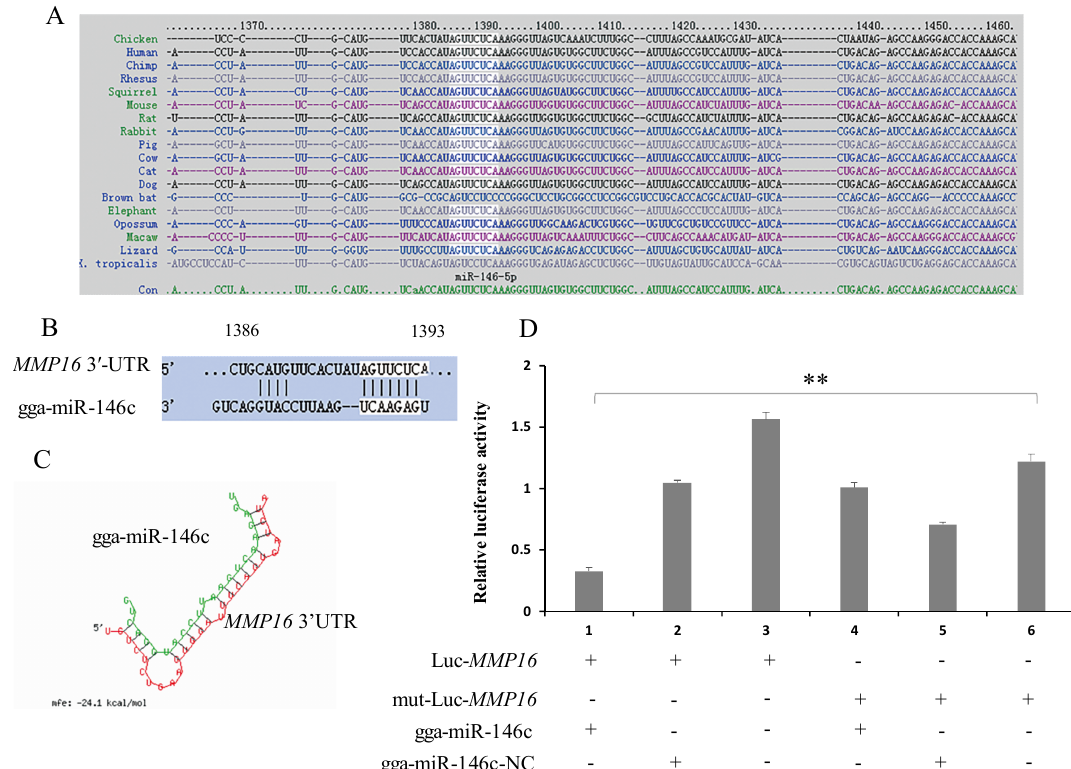
Figure 2. MMP16 is a target of gga-miR-146c. ( A ) Alignment of MMP16 3′-UTR from different species. The highlighted sequence is conserved region; ( B ) Alignments of gga-miR-146c and the target site in MMP16 3′-UTR. The highlighted part is gga-miR146c seed sequence; ( C ) Structure of gga-miR-146c and MMP16 3′-UTR target site. Red strand represents target sequence and green represents gga-miR146c; ( D ) Luc-MMP16 (3′-UTR) and either gga-miR-146c or gga-miR-146c-NC were co-transfected into cells. The dual-luciferase glow assay was performed 24 h transfection later. Data from three experiment results were mean ± SD. Two-tailed Student’s t-test, ** P < 0.01.